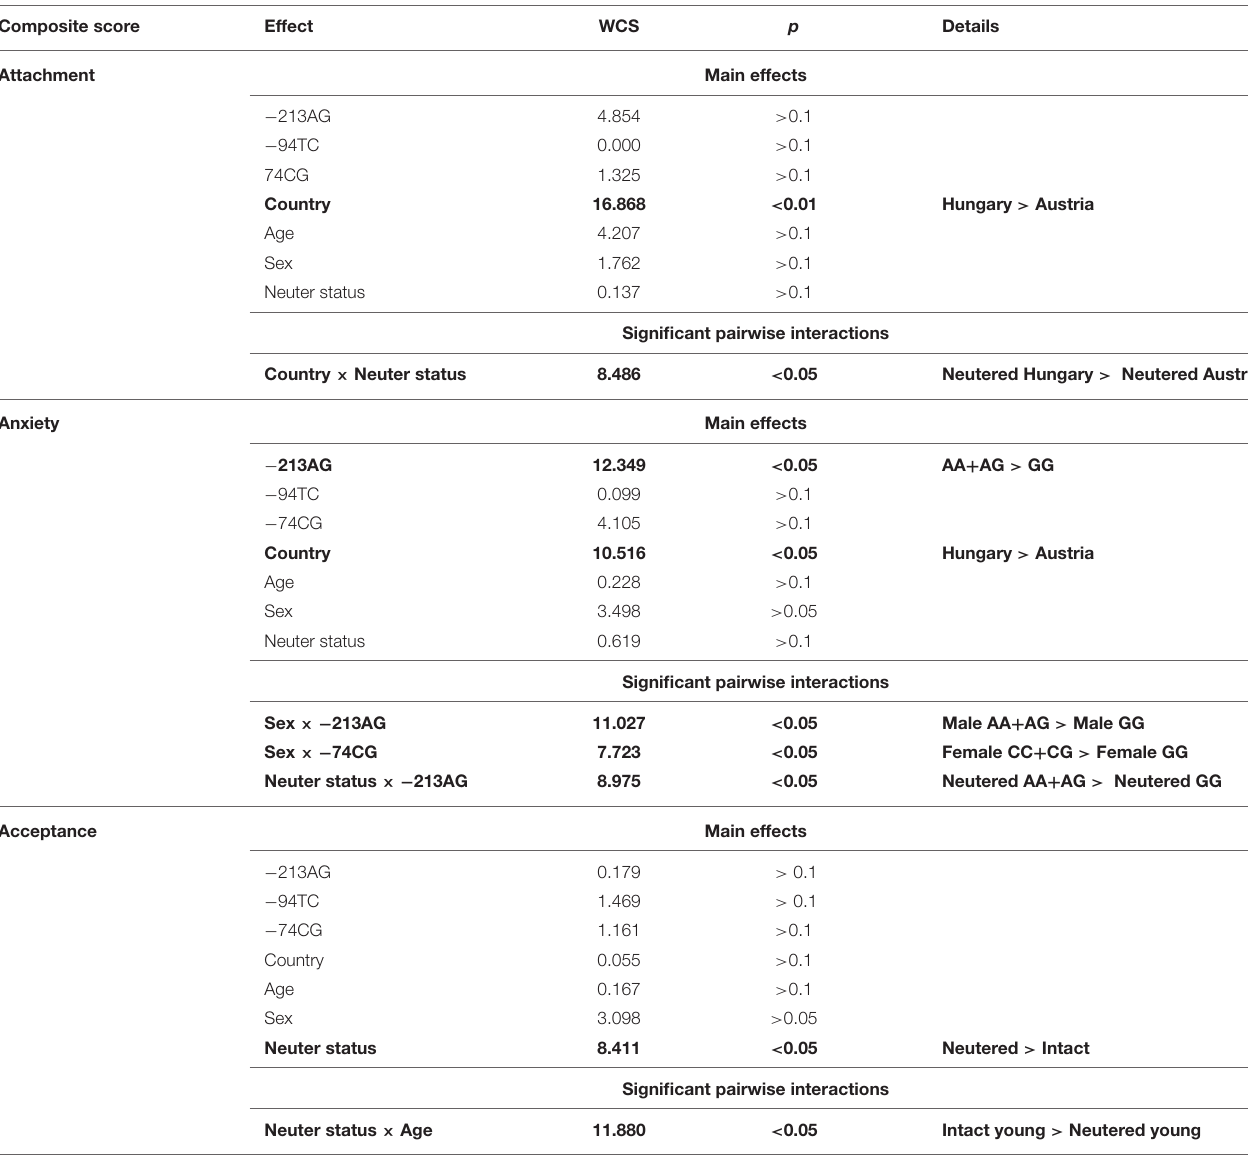
TABLE 5 | The effects of dog OXTR polymorphisms and dog characteristics on Attachment, Anxiety, and Acceptance composite scores as measured in the Strange Situation Test. Composite